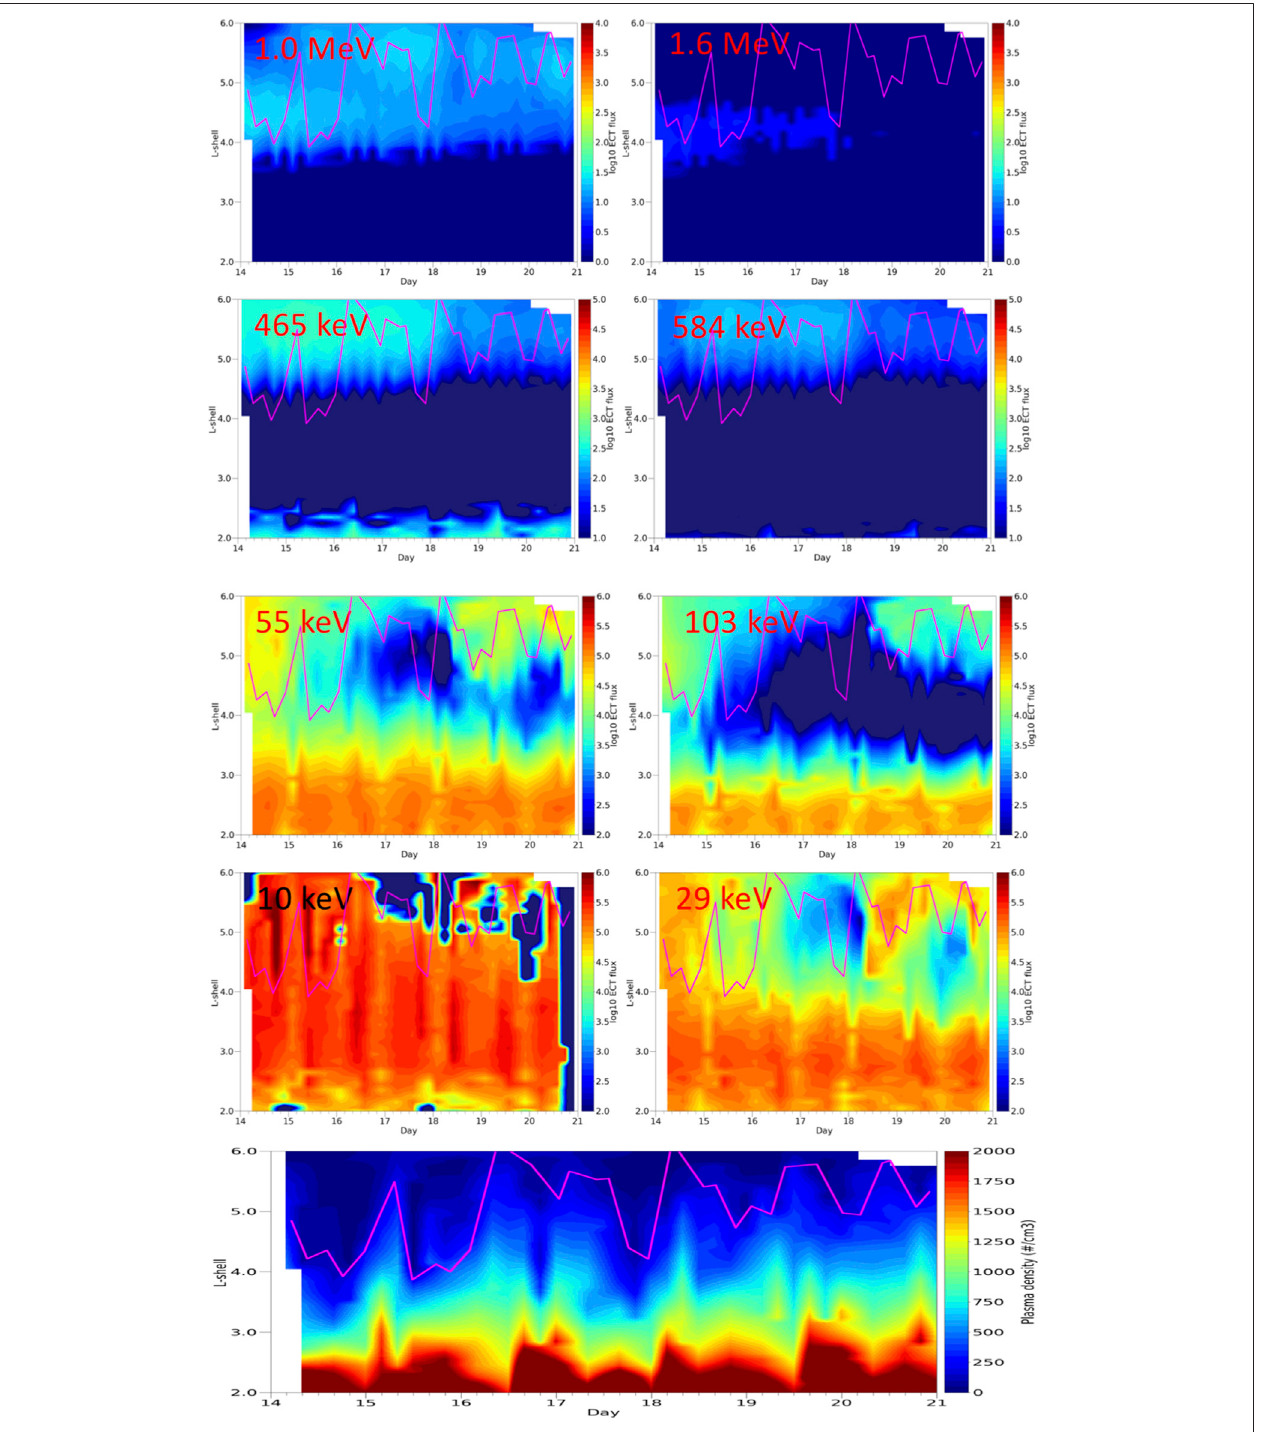
FIGURE 7 | (Top four panels) Radiation belt fl ux versus time and L-shell for sub-relativistic and relativistic electrons for the quiet period of 14 – 20 March 2014 measured by the Van Allen Probes/ECT suite in the magnetic equatorial plane. (Next four panels) Low energy seed electrons (10 – 100 keV), which contribute to the electromagnetic environment and as source of aurora. The magenta line corresponds to the plasmapause position measured by EMFISIS on RBSP A. (Bottom panel) Density measured by RBSP A/EMFISIS during the same period.